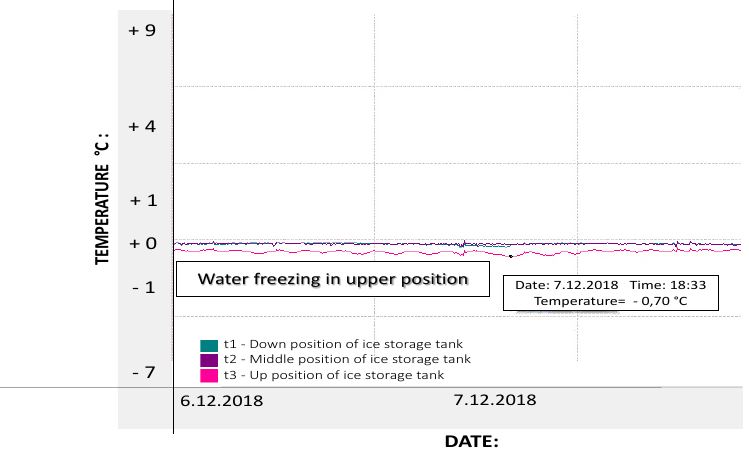
Figure 18. III. Phase: 0—Freezing in upper position t3.